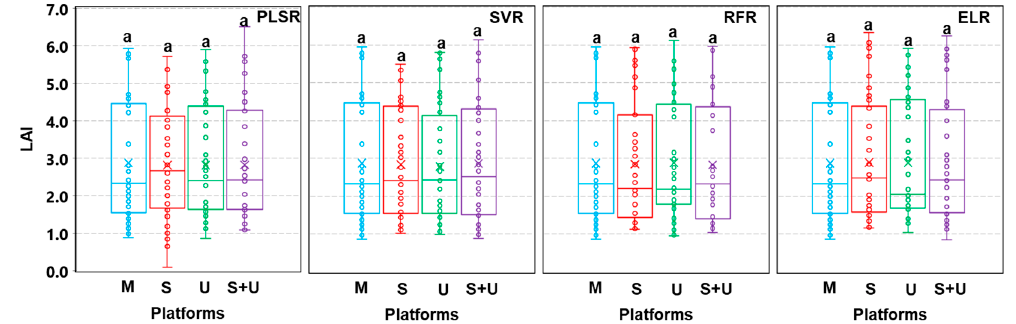
Figure 6. Boxplot for measured (M) and predicted LAI using satellite (S), UAV (U), as well as combined satellite and UAV (S + U), data from each model. ANOVA was carried out, and the letter ‘a’ on the bars indicate no significant differences according to the HSD Tukey's test ( α = 0.05).